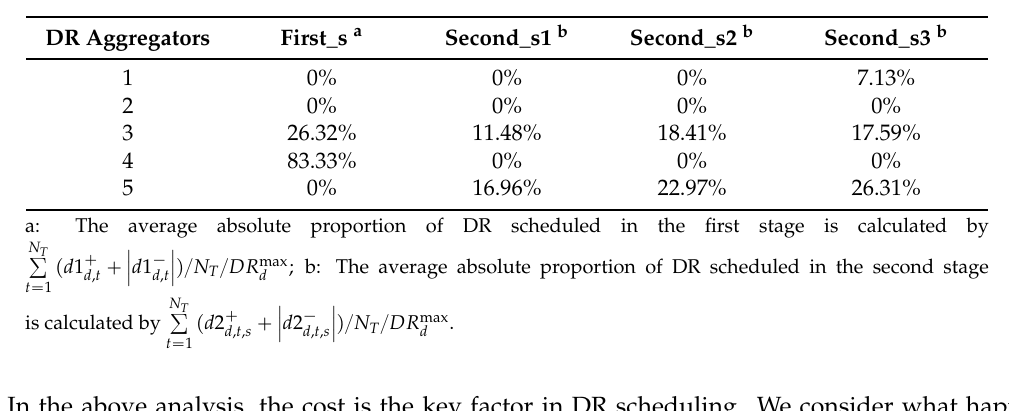
Table 4. Average absolute proportion of DR scheduled in each stage for each aggregator (without transmission